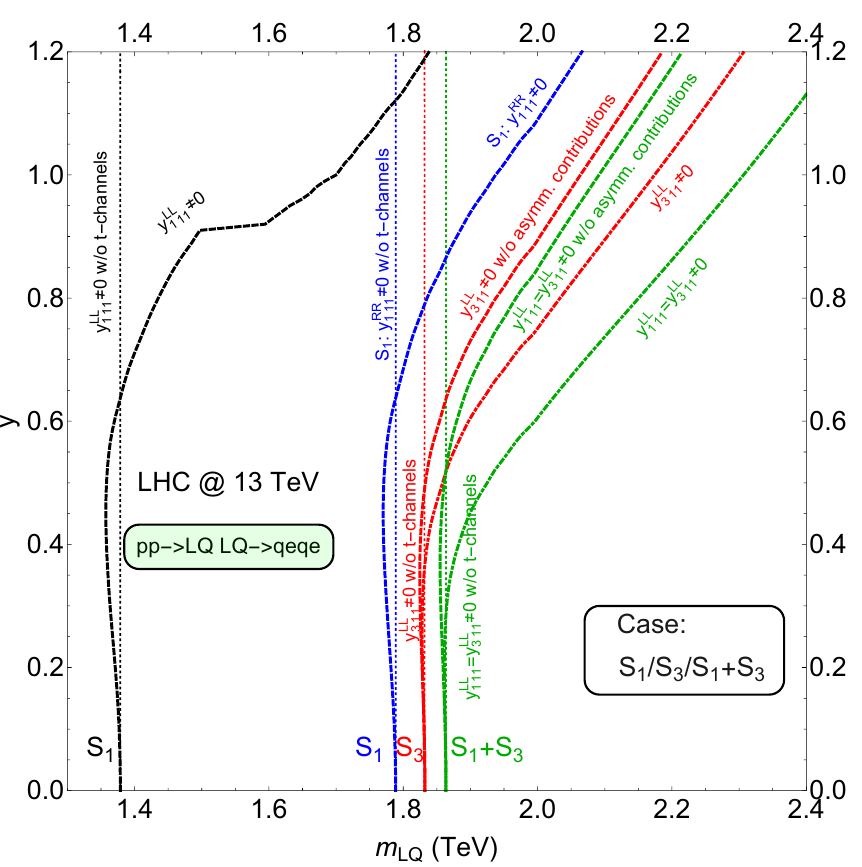
Figure 9 . The leptoquark parameter space limits for the S 1 , S 3 , and S 1 + S 3 scenarios extracted from the pp → LQLQ → jjee process search [1] performed at 13 TeV center-of-mass energy of proton-proton collisions at the LHC, using an integrated luminosity of 139 fb − 1 . See text for more